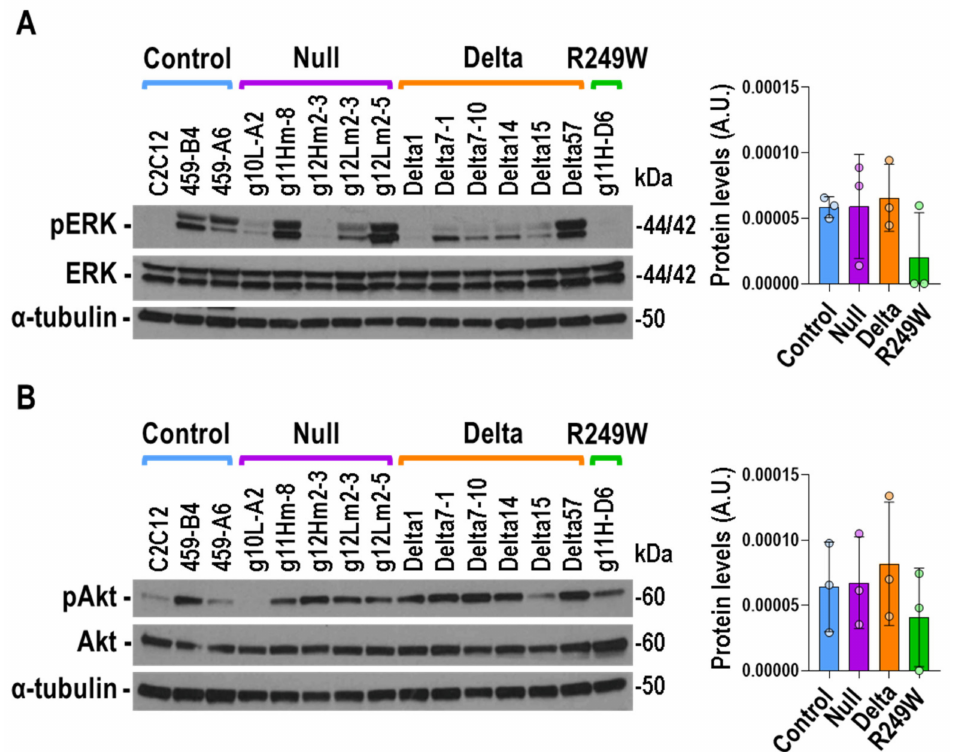
Figure 6. No di ff erences in ERK1 / 2 and AKT activation were detected in Lmna exon 4 mutant myoblasts. ( A ) Representative immunoblot for the detection of phosphorylated (pERK) and total (ERK) ERK1 / 2 in Lmna exon 4 mutants. ( B ) Representative immunoblot for the detection of phosphorylated (pAKT) and total (AKT) AKT. Detection of α -tubulin was used in all the cases as loading control. Data in bar graphs are mean ± SEM of all the clones of each type, n = 3. No significant di ff erences were detected when mutants were compared with controls using a two-tailed, unpaired Student’s t